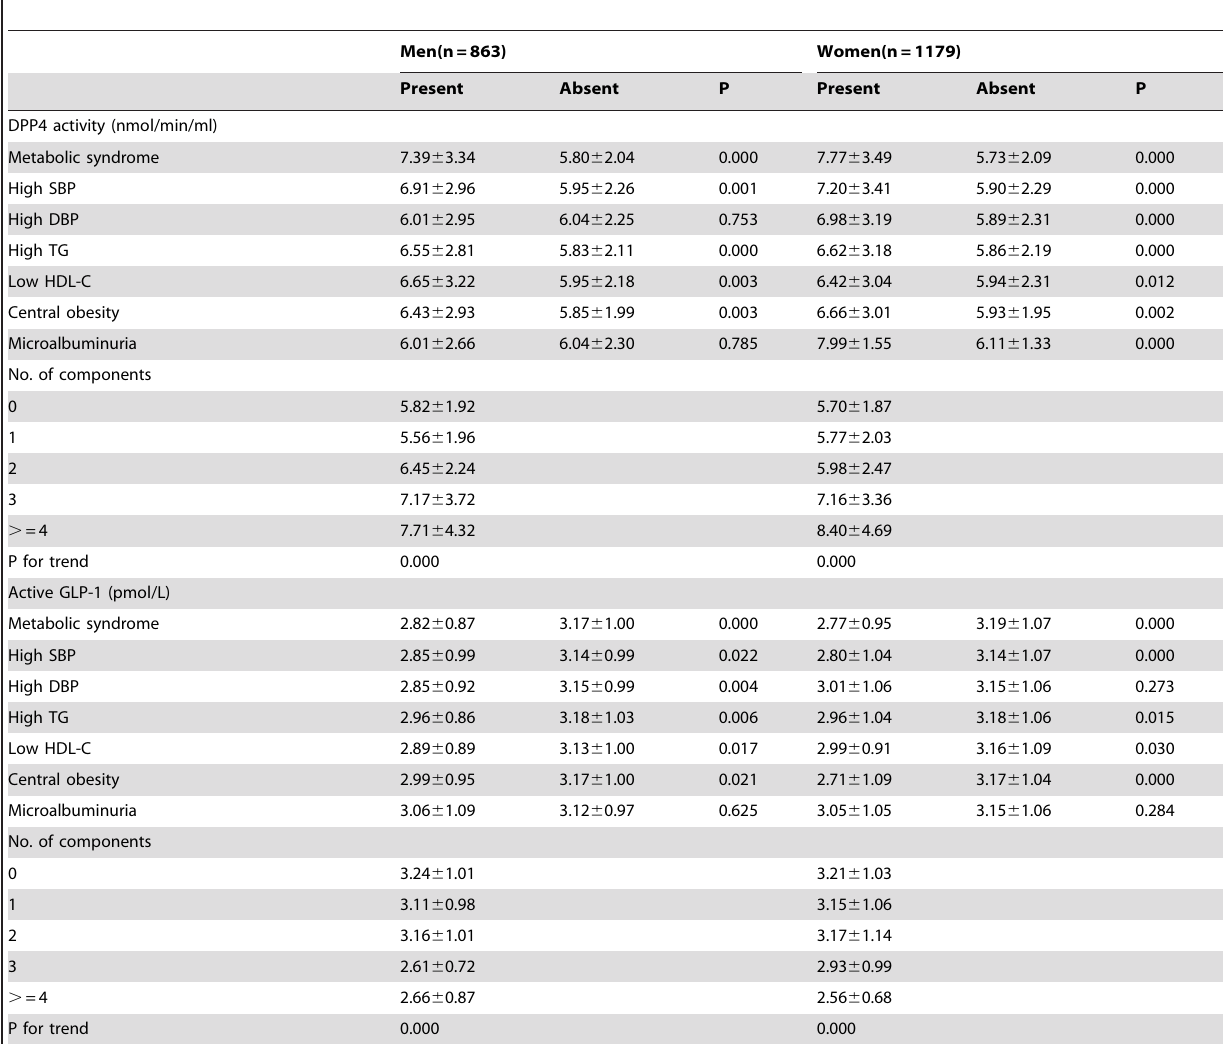
Table 2. Baseline DPP4 activity and active GLP-1 according to presence or absence of components of new-onset metabolic